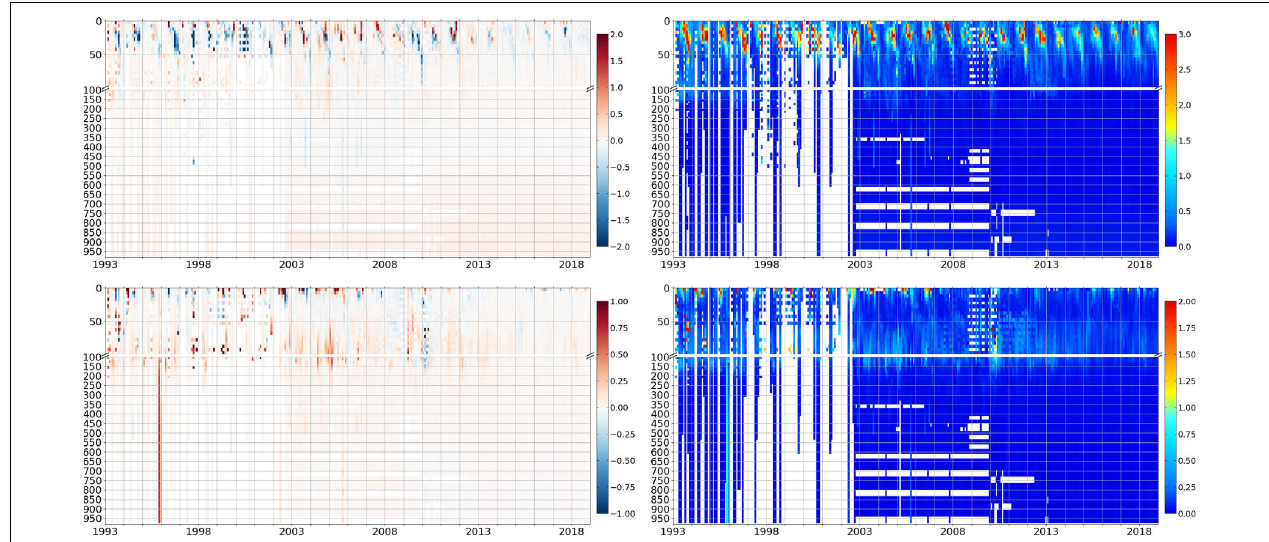
FIGURE 4 | Monthly Hovmöller diagrams of bias (left) and root mean square difference (right) computed against observations of temperature in ◦ C (top) and salinity in PSU (bottom) available in the Black Sea domain from 1 January 1993 to 31 December 2018.